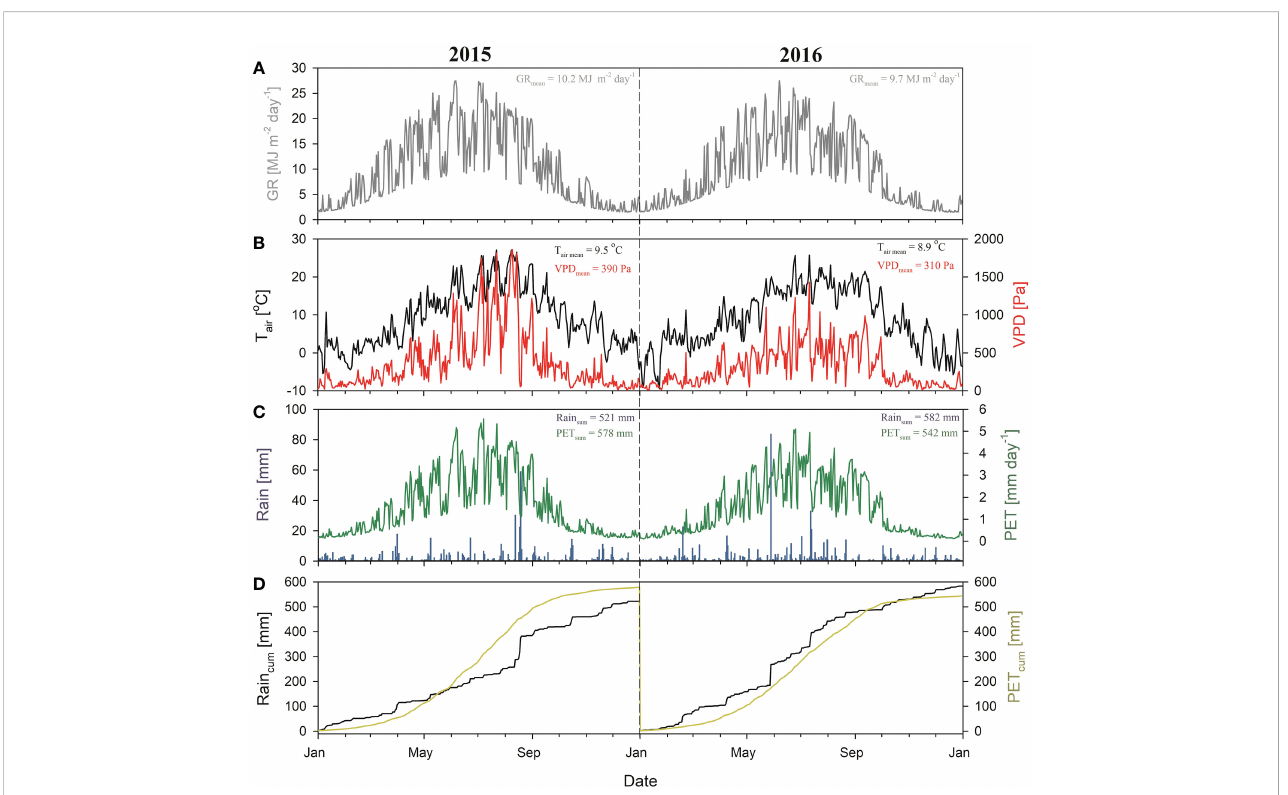
FIGURE 2 Microclimatic variables in 2015 and 2016 on the studied site. Daily sums of global radiation - GR (A) , daily mean air temperature - Tair and vapor pressure de fi cit - VPD (B) , daily precipitation - Rain and potential evapotranspiration - PET (C) , cumulative precipitation - Raincum and cumulative potential evapotranspiration - PETcum (D) . The difference between PETcum and Raincum is Cumulative Water De fi cit